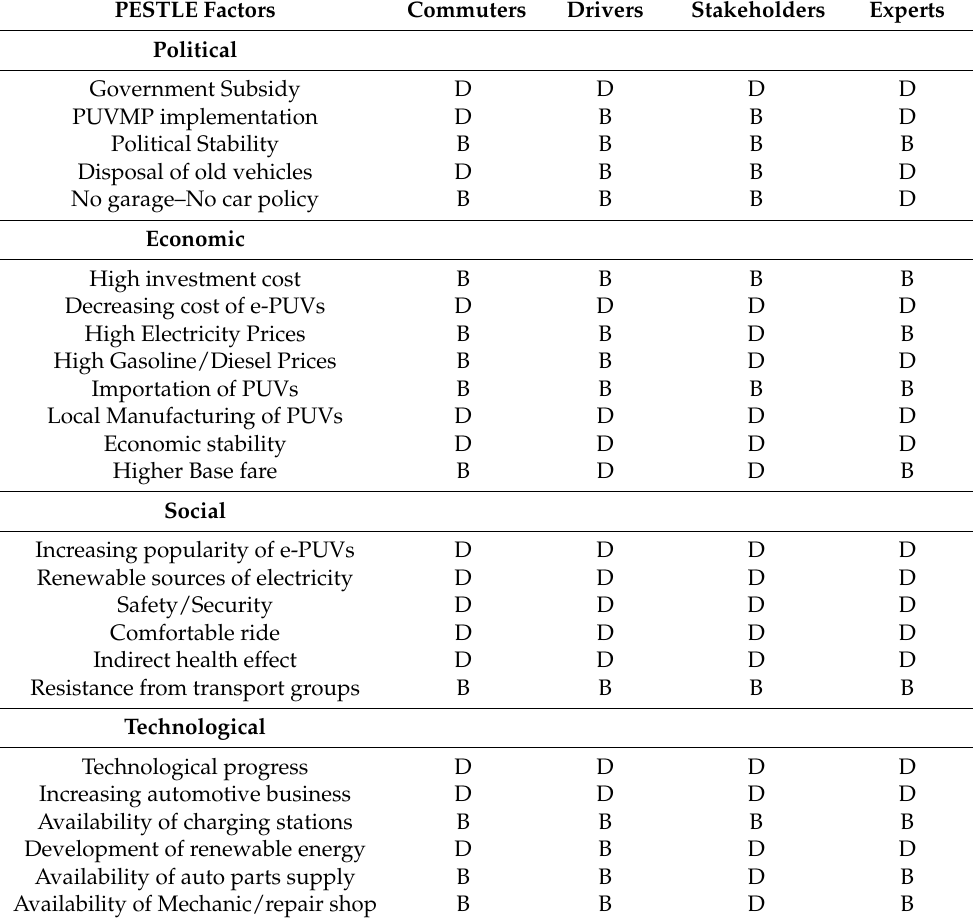
Table 2. Barriers and drivers for the adoption of electric vehicles (EVs) for public transport (D = driver, B =